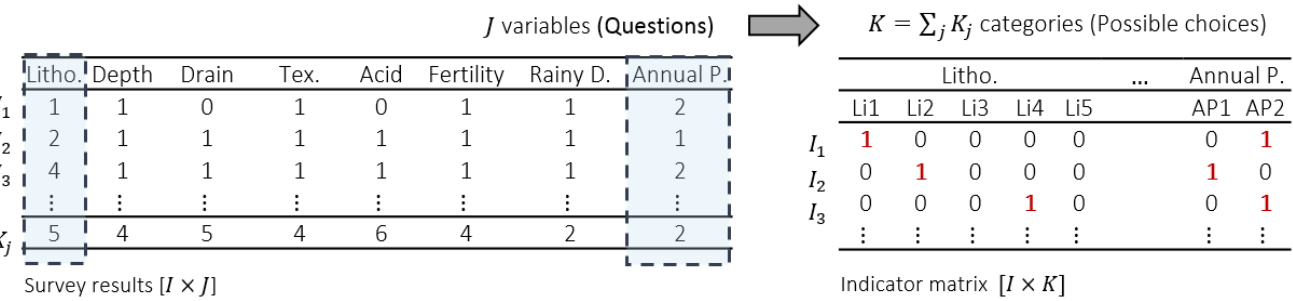
Figure 5. Indicator matrix